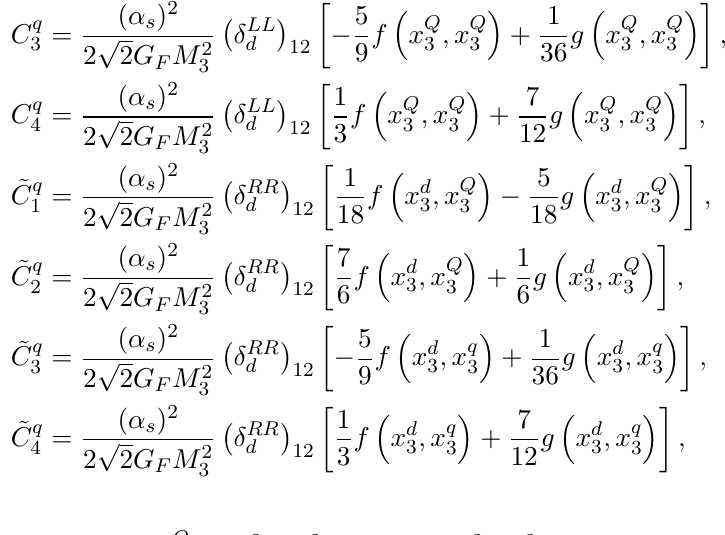
Figure 9 . A CP vs. B ( K 0 ! (cid:22) + (cid:22) (cid:0) ) (left) and vs. " 0 =" K (right). The top panels correspond to S K (cid:0) (cid:1) Scenario A, (cid:14) LL 6 = 0 and ( M 3 (cid:1) (cid:22) ) < 0. The bottom panels correspond to Scenario B, d 12 and ( M 3 (cid:1) (cid:22) ) > 0. The plots are done for D = (cid:0) D 0 = 0 : 5 . The cyan dots correspond to A (cid:22) and the orange crosses to A (cid:22) < 0. The deep purple bands correspond to the experimental value of L(cid:13)(cid:13) " 0 =" K , the vertically hatched areas correspond to the SM prediction for A (cid:22) K hatched areas to the SM prediction for A (cid:22) < 0 L(cid:13)(cid:13)